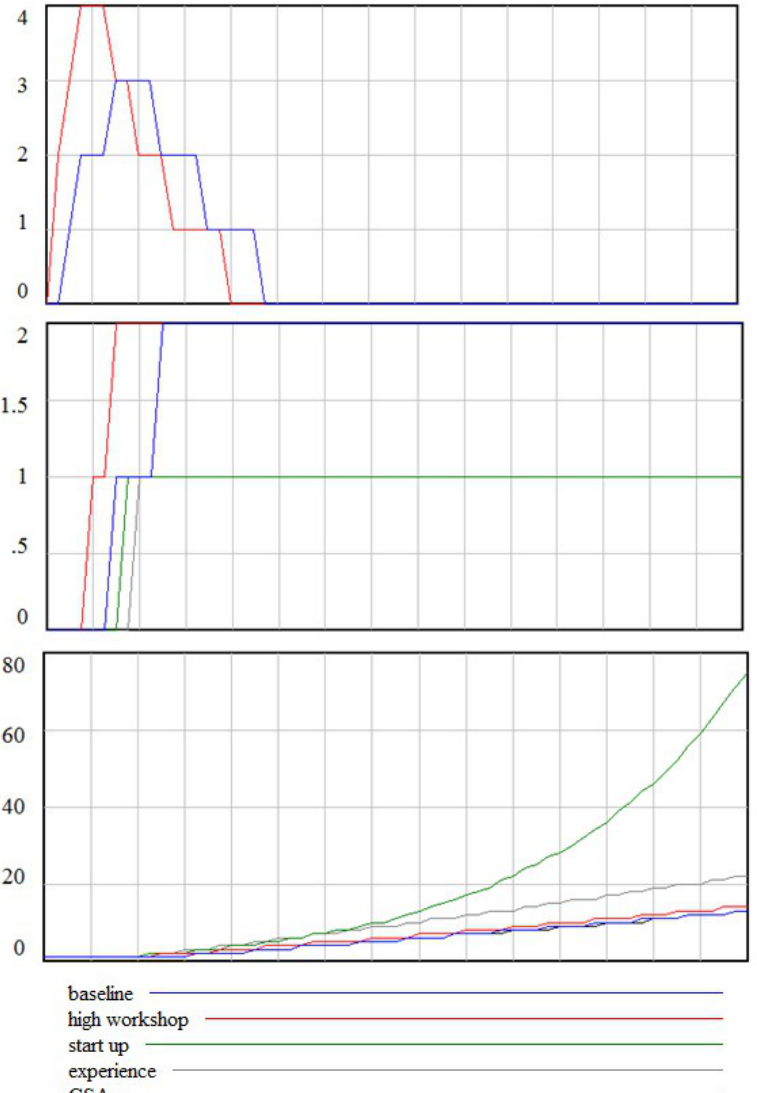
Model Output: Results of Program